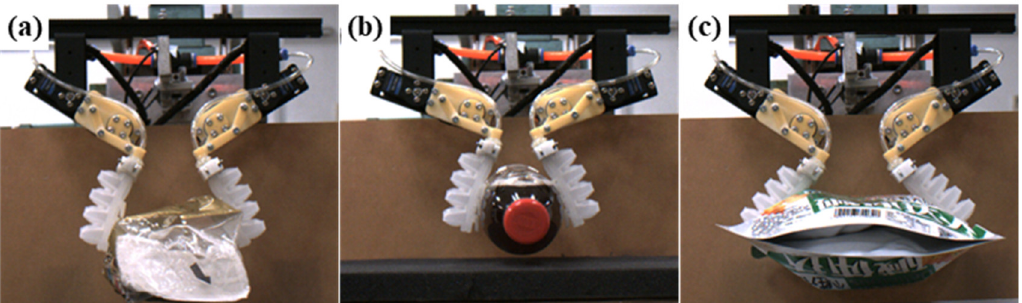
Figure 9. Application of the Bio-AU: ( a ) flexible hand-pulled paper bag weighing 54 g; ( b ) coke weighing 482 g; and ( c ) snacks weighing 200 g. weighing 482 g; and ( c ) snacks weighing 200